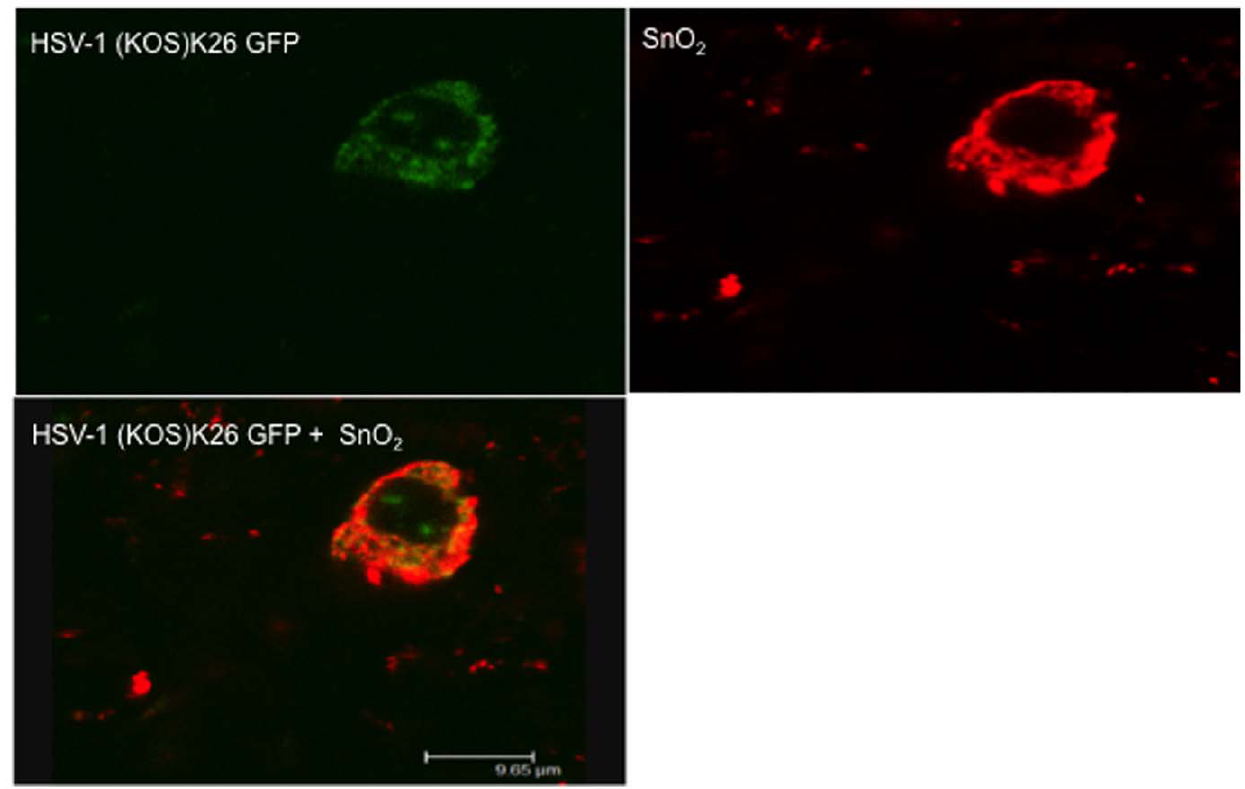
Figure 6. SnO 2 exhibits HSV-1 binding ability. A binding assay was preformed to determine the interactions of SnO 2 with K26 GFP virus. A SnO 2 solution was placed into an Eppendorf tube and stained with Rhodamine phalloidin [red](Invitrogen) for 20 minutes, washed with PBS, and incubated with HSV-1 (KOS) K26GFP for 2 hours at 37 u C. Leica Confocal microscopy software was utilized to identify co-localization of SnO 2 with HSV-1.